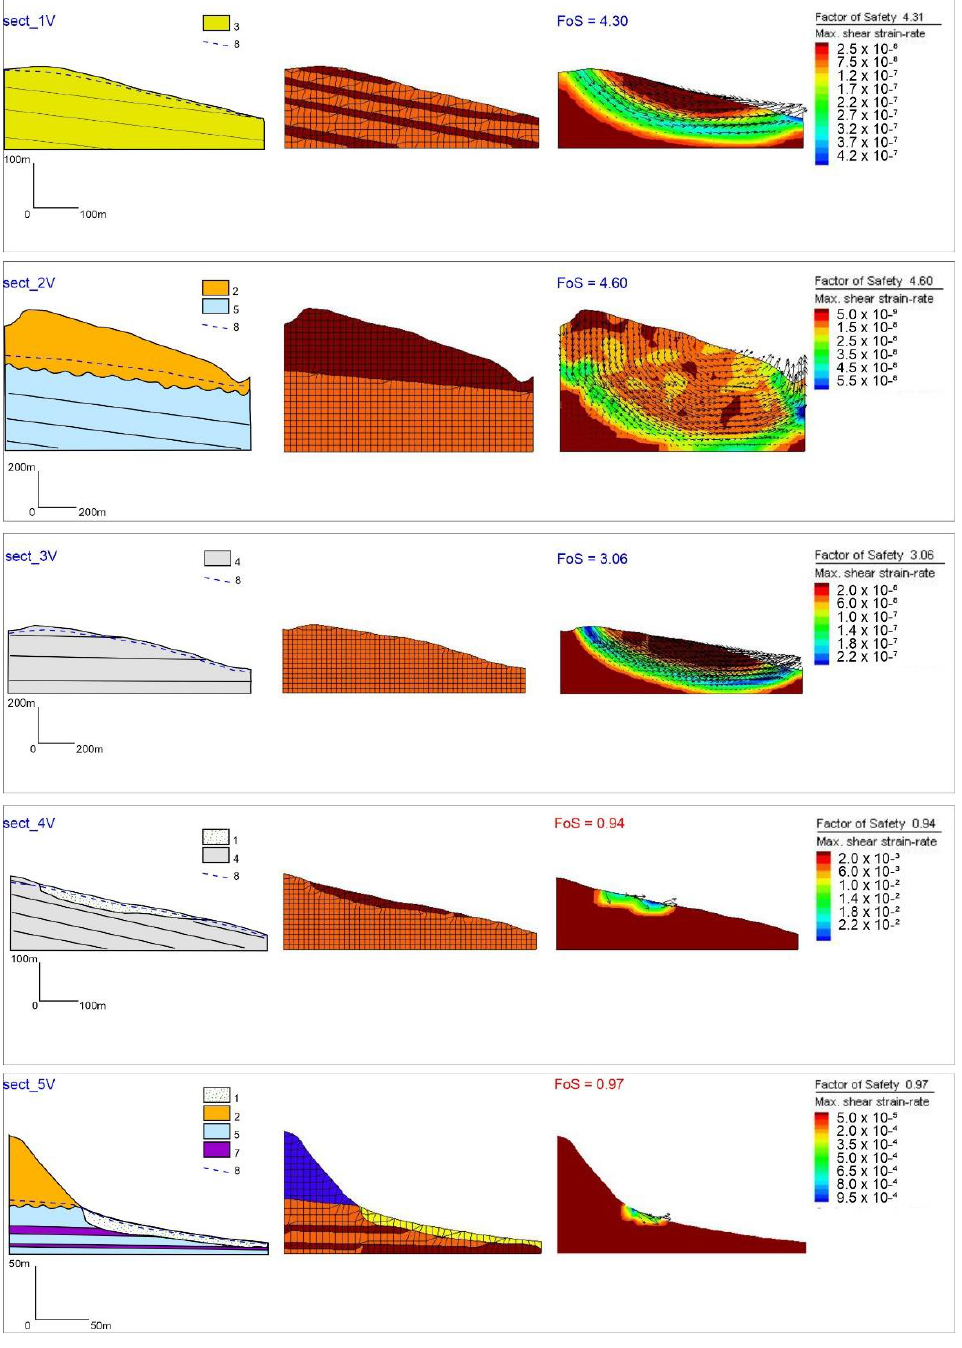
Figure 8. Results of numerical simulation (Sections 1V, 2V, 3V, 4V, 5V). From left to right: geotechnical cross-section, mesh and model result. 1 — slope and colluvial deposits; 2 — arenaceous-conglomeratic bedrock; 3 — arenaceous-pelitic and pelitic-arenaceous bedrock; 4 — mainly clayey bedrock; 5 — mainly pelitic-arenaceous bedrock; 6 — mainly arenaceous-pelitic bedrock; 7 — weak layer/ductile deformation zone; 8 — water table.